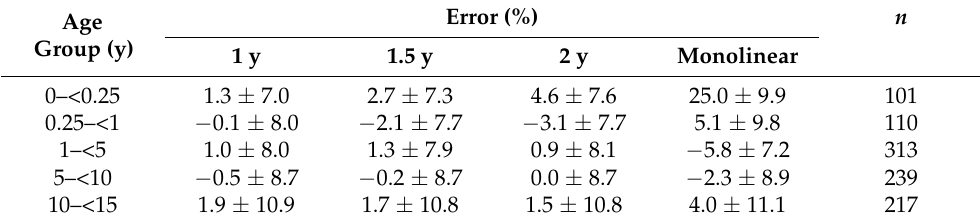
Table 3. Age cutoffs for bilinear fitting and error of CTDIvol estimation.